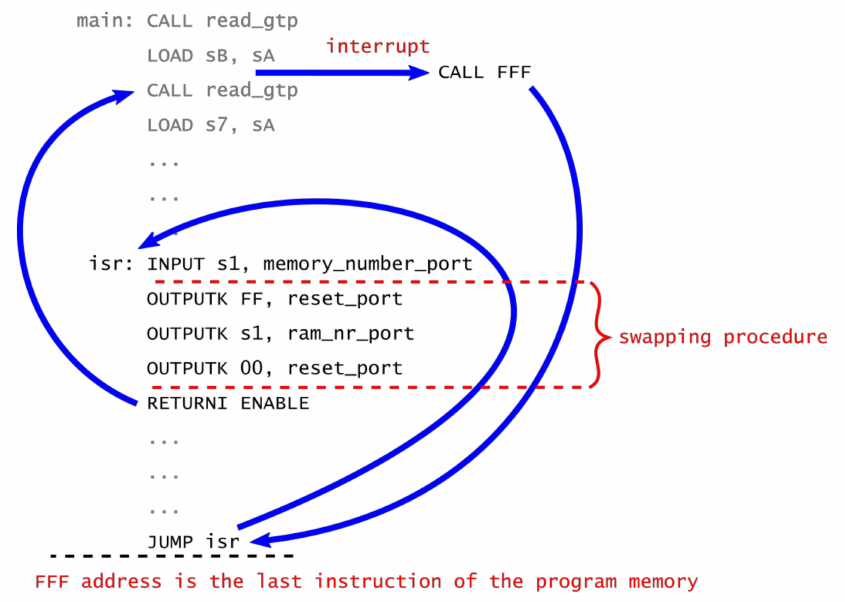
Figure 6. The controller code for dynamic reconfiguration. Reconfiguration triggered using an interrupt.